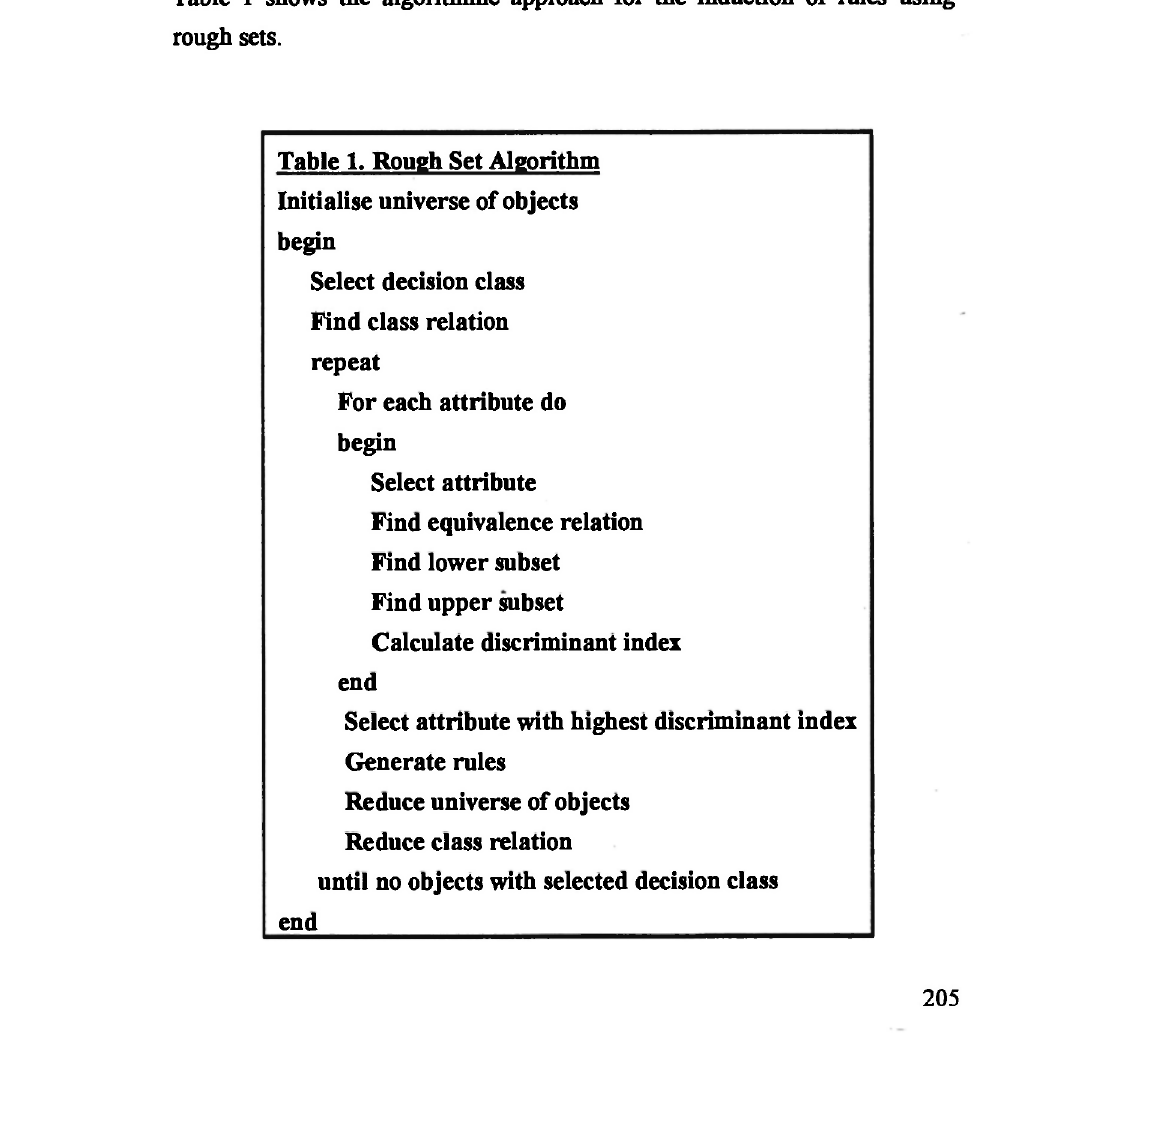
Table 1. Rough Set